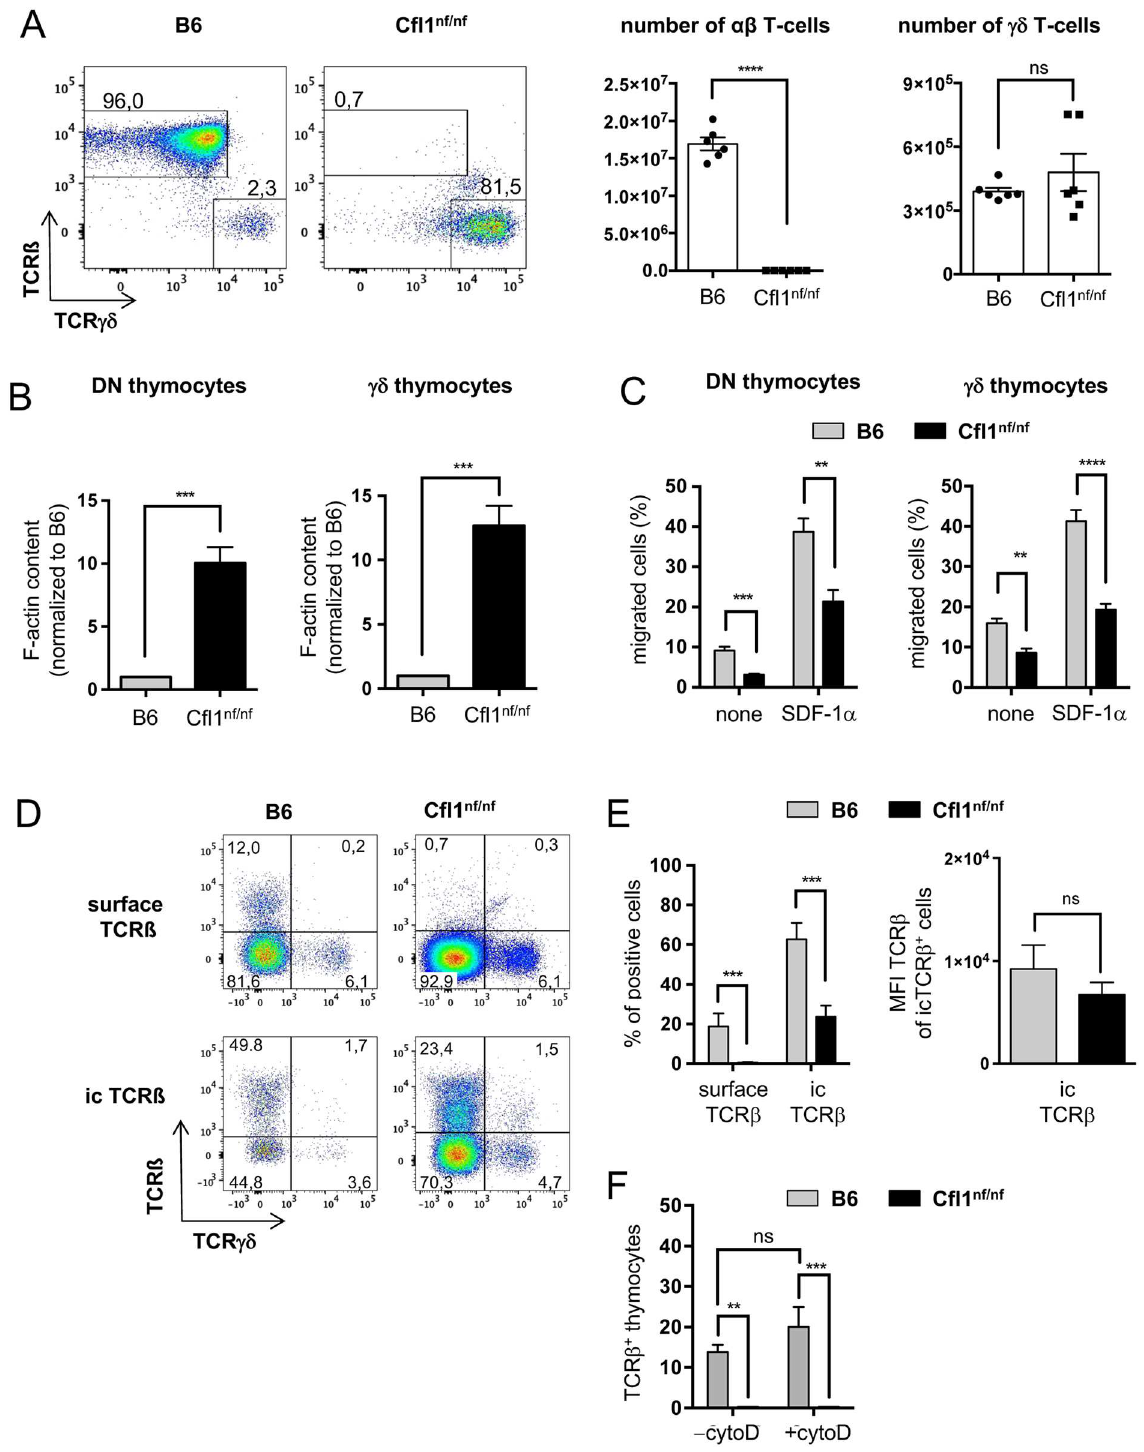
Fig 3. DN thymocytes of Cfl1 nf/nf mice show a dramatically enhanced F-actin content and impaired migratory capacity as well as a lack of TCR β surface expression. (A) CD3 + splenocytes were analyzed for expression of TCR β and TCR γδ .Shown are representative dot blots (left panels) and calculated absolute cell numbers (right panel) of TCR β and TCR γδ expressing cells. Data is represented as mean ± SEM and summarizes 3 independent experiments with a total of 6 mice per group. (B) Total F-actin amount of DN thymocytes or γδ thymocytes